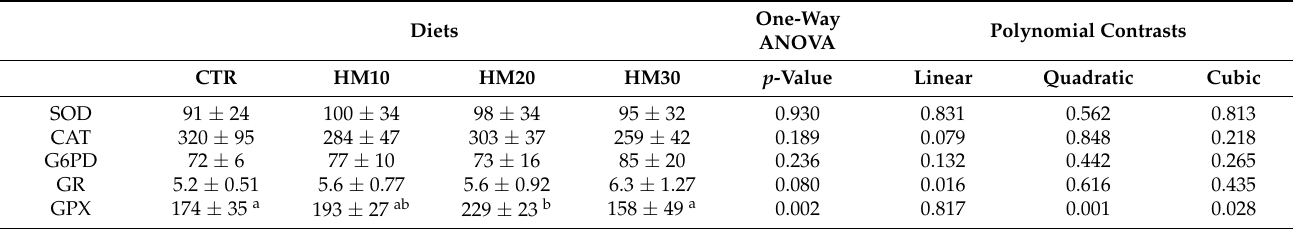
Table 1. Hepatic levels of superoxide dismutase (SOD) and catalase (CAT) (U mg protein − 1 ), glucose- 6-phosphate dehydrogenase (G6PD), glutathione reductase (GR), and glutathione peroxidase (GPX) (mU mg protein − 1 ) activities in meagre juveniles fed the experimental diets with different levels of Hermetia meal (HM).